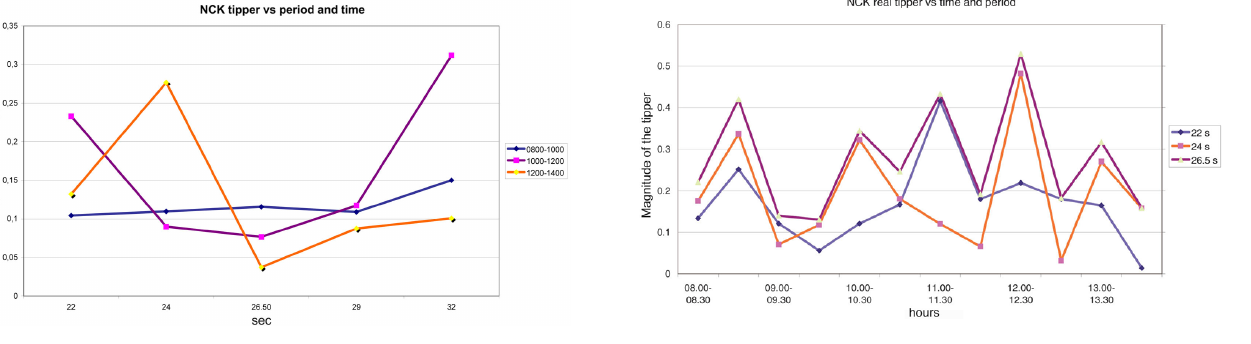
Fig. 8. NCK real tippers vs. period in 2-h sections (FLR periods, 22–32 s).